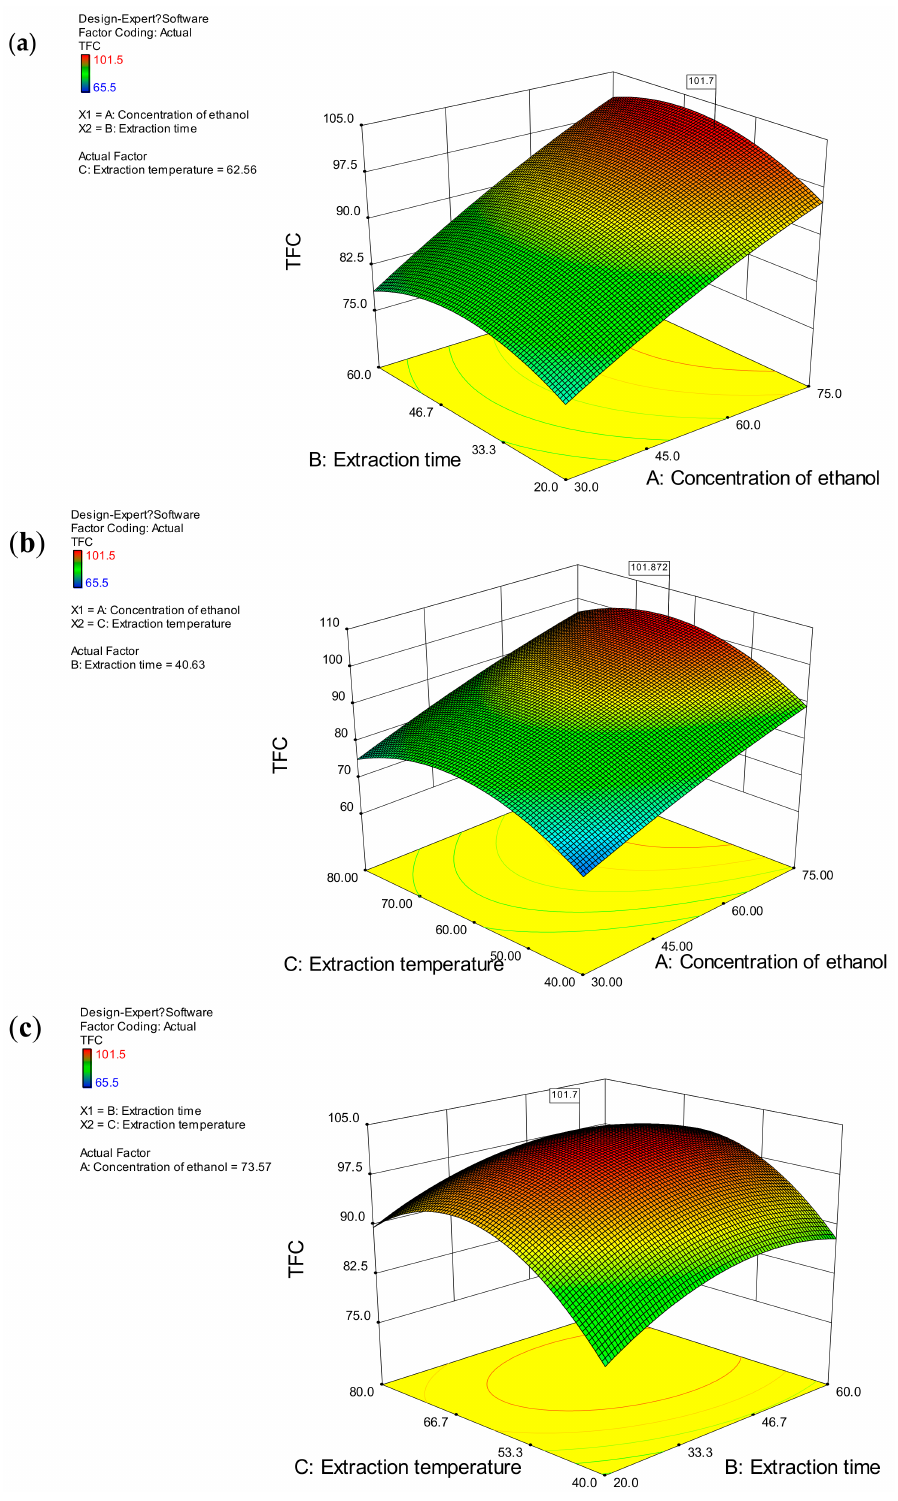
Figure 2. Response surface plots (3D) showing the effects of different extraction parameters including ( a ) concentration of ethanol; ( b ) extraction time and ( c ) extraction temperature on the